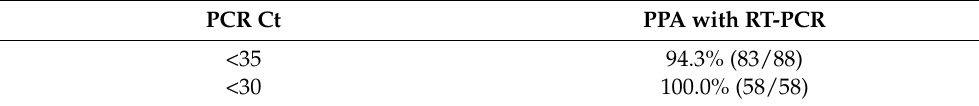
Table 1. Percent positive agreement with RT-PCR.